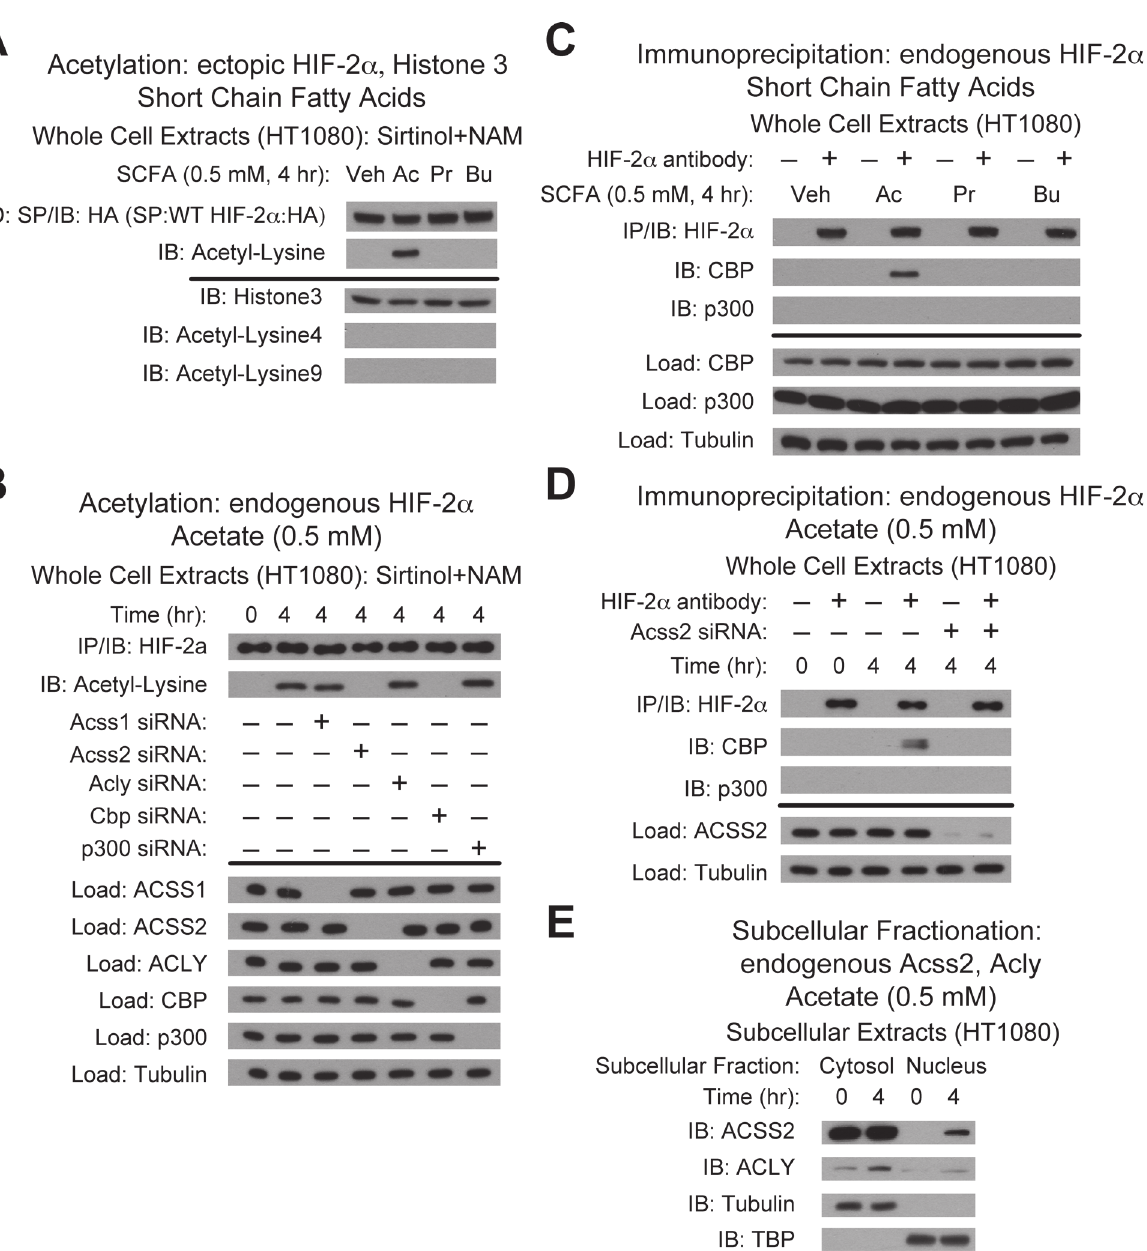
Fig 3. Acetate induces ACSS2-dependent CBP/HIF-2 α interactions. (A) Acetylation of ectopic HA-tagged wild-type HIF-2 α after pulldown (PD) and detection by immunoblotting (IB) after (4 hr) incubation with vehicle (Veh), or the short chain fatty acids acetate (Ac), propionate (Pr), and butyrate (Bu) with pharmacological inhibition of Sirt1 by sirtinol and nicotinamide (NAM). (B) Acetylation of endogenous HIF-2 α after immunoprecipitation (IP) and detection by immunoblotting (IB) after (4 hr) incubation with acetate and following control, ACSS1, ACSS2, ACLY, CBP or p300 knockdown. (C) Endogenous CBP/HIF-2 α or p300/HIF-2 α complexes after (4 hr) treatment with vehicle (Veh), acetate (Ac), propionate (Pr), or butyrate (Bu). (D) Endogenous CBP/HIF-2 α or p300/HIF- 2 α complexes detected by immunoblotting (IB) after (4 hr) acetate exposure following ACSS2 knockdown. (E) Detection of ACSS2 or ACLY in HT1080 subcellular fractions by immunoblotting (IB) after (4 hr) acetate exposure. Experiments in (A)-(D) performed with HT1080 whole cell extracts.